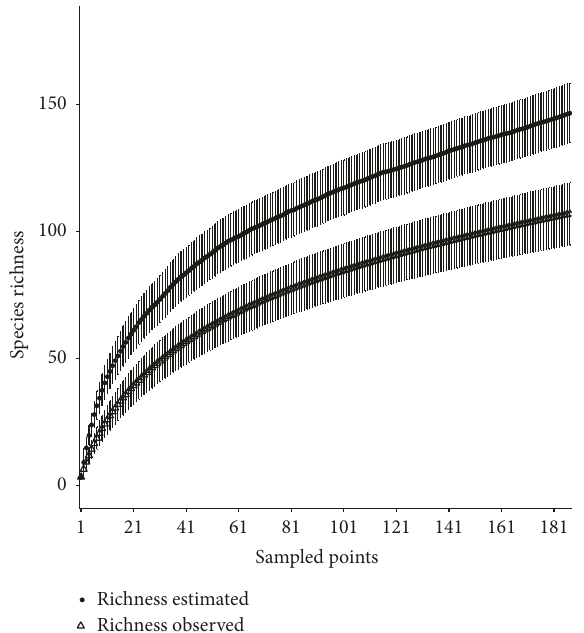
Figure 2: Accumulation curves of observed and estimated species from Parque Estadual Mata Atlˆantica (PEMA). Dots and triangles indicate the species richness; bars indicate confidence intervals (𝑝 < 0.05) .